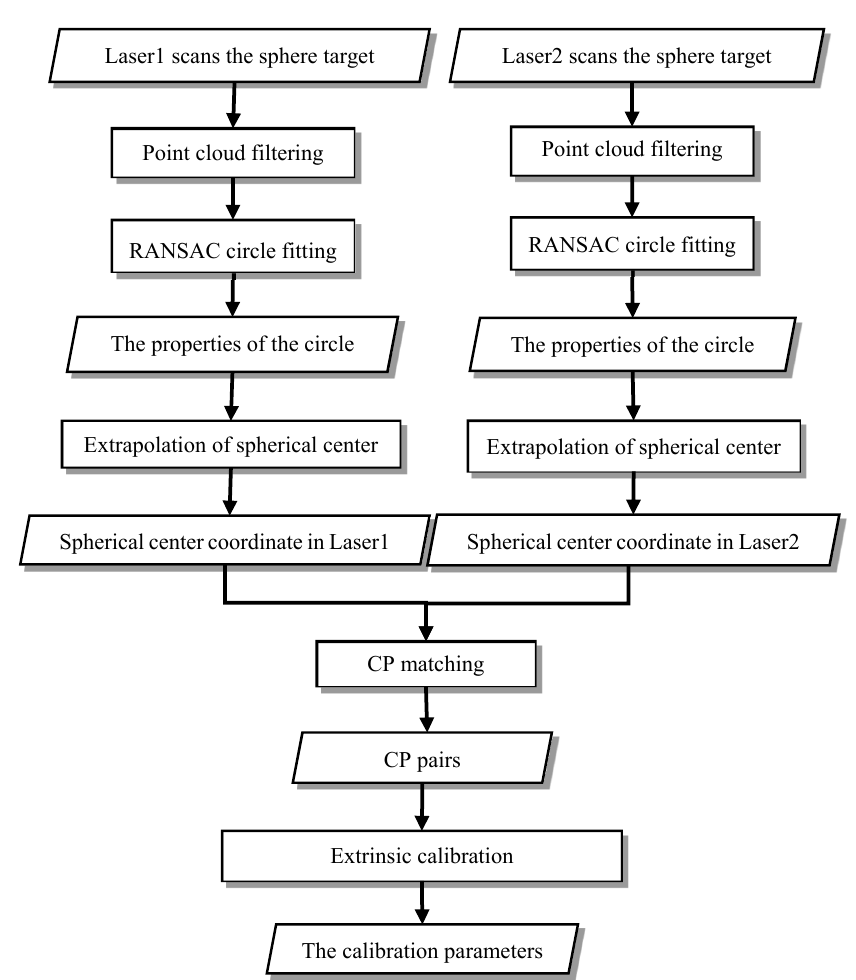
Figure 3. Extrinsic calibration process between Laser1 and Laser2 based on a mobile sphere. Step 1: calculation of the spherical center, including point cloud filtering, random circle consensus (RANSAC) circle fitting and extrapolation of the spherical center. Step 2: CP matching based on the sample timestamp alignment. Step 3: establishing and solving the extrinsic calibration model.